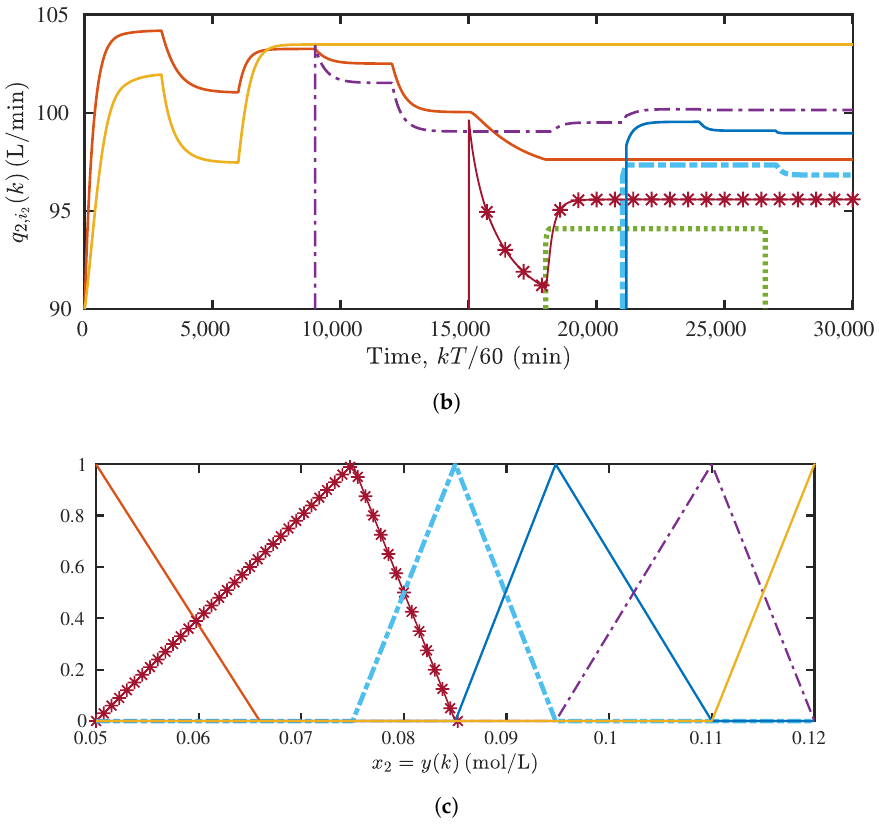
Figure 6. Evolution of the antecedent and consequent parameters of x 2 = y ( t ) . ( a ) Evolution of the antecedent parameters of x 2 = y ( t ) . ( b ) Evolution of the consequent parameters of x 2 = y ( t ) . ( c ) Final membership functions of x 2 = y ( t )